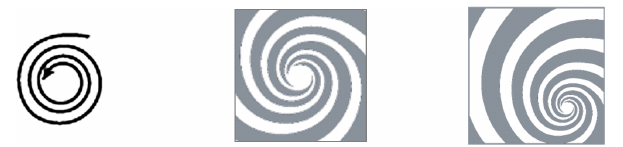
Figure 12. Evolution of the fifth pattern.